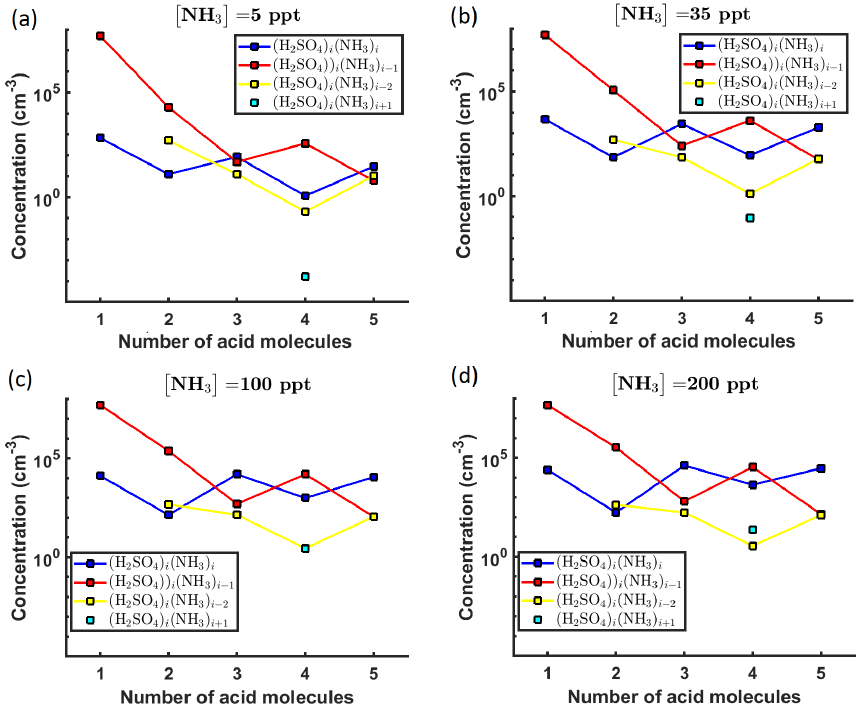
Figure 2. Steady-state cluster concentrations for the clusters containing sulfuric acid and a varying number of ammonia molecules, as a function of the number of acid molecules, for [ NH 3 ] mixing ratios of (a) 5ppt, (b) 35ppt, (c) 100ppt and (d) 200ppt at the temperature T = 278K. The concentrations have been amended with multivariate non-correlated Gaussian noise with standard deviation comprising 0.001% of the original cluster concentration. The source rate of sulfuric acid monomers comprises 6 . 3 × 10 4 s − 1